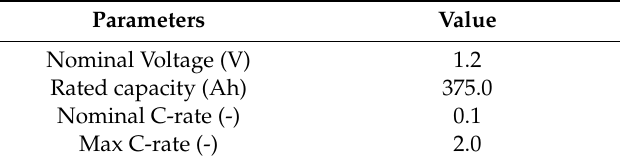
Figure 3. Scheme of the tested platform. Table 4. Features of the Ferak KPL 375 NiCd batteries [24].